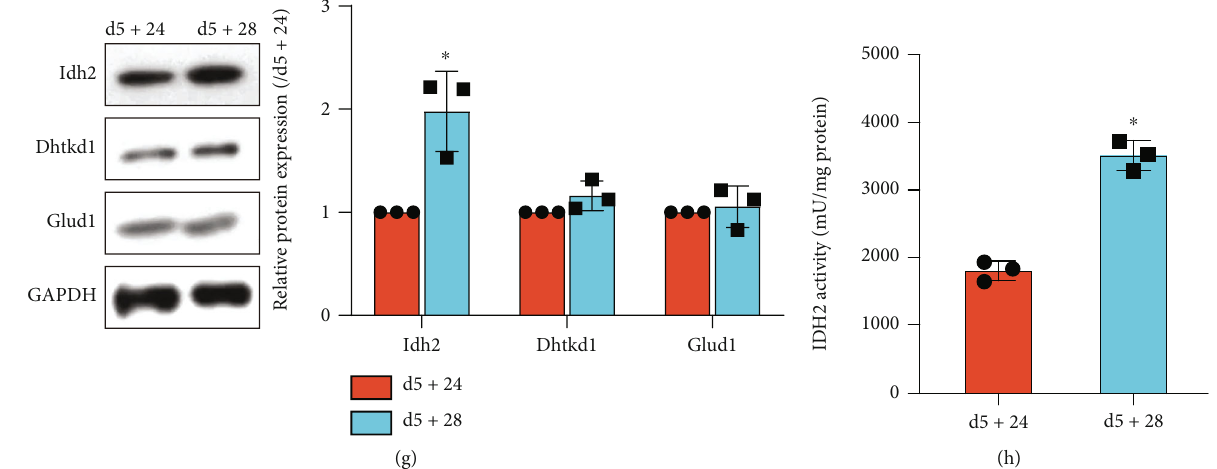
Figure 4: Bioinformatics analysis of Mfn2 in immature and mature β cells. (a, b) Mfn2 expression at di ff erent time points during β cell maturation in GSE54374 (a) and GSE87375 (b). (c, d) KEGG pathway (c) and GO biological process pathway (d) enrichment in highly correlated genes with Mfn2. The top 10 pathways ranked by adjust P values were listed in bubble charts. (e) Expression heat map of selected highly correlated genes and Mfn2. Genes with adjust P value < 0.05 and ∣ foldchange ∣ >1 : 5 were set as signi fi cant DEGs. Blue charts indicated downregulated DEGs, and red charts indicated upregulated DEGs in 8-12-week β cells. (f) mRNA expressions of signi fi cant DEGs detected by qRT-PCR. (g) Protein expression detected by western blot. (h) Idh2 activity detected by Idh activity assay kit. n = 3 . Data are means ± S : D . ∗ P < 0 : 05 vs. day 5 + 24